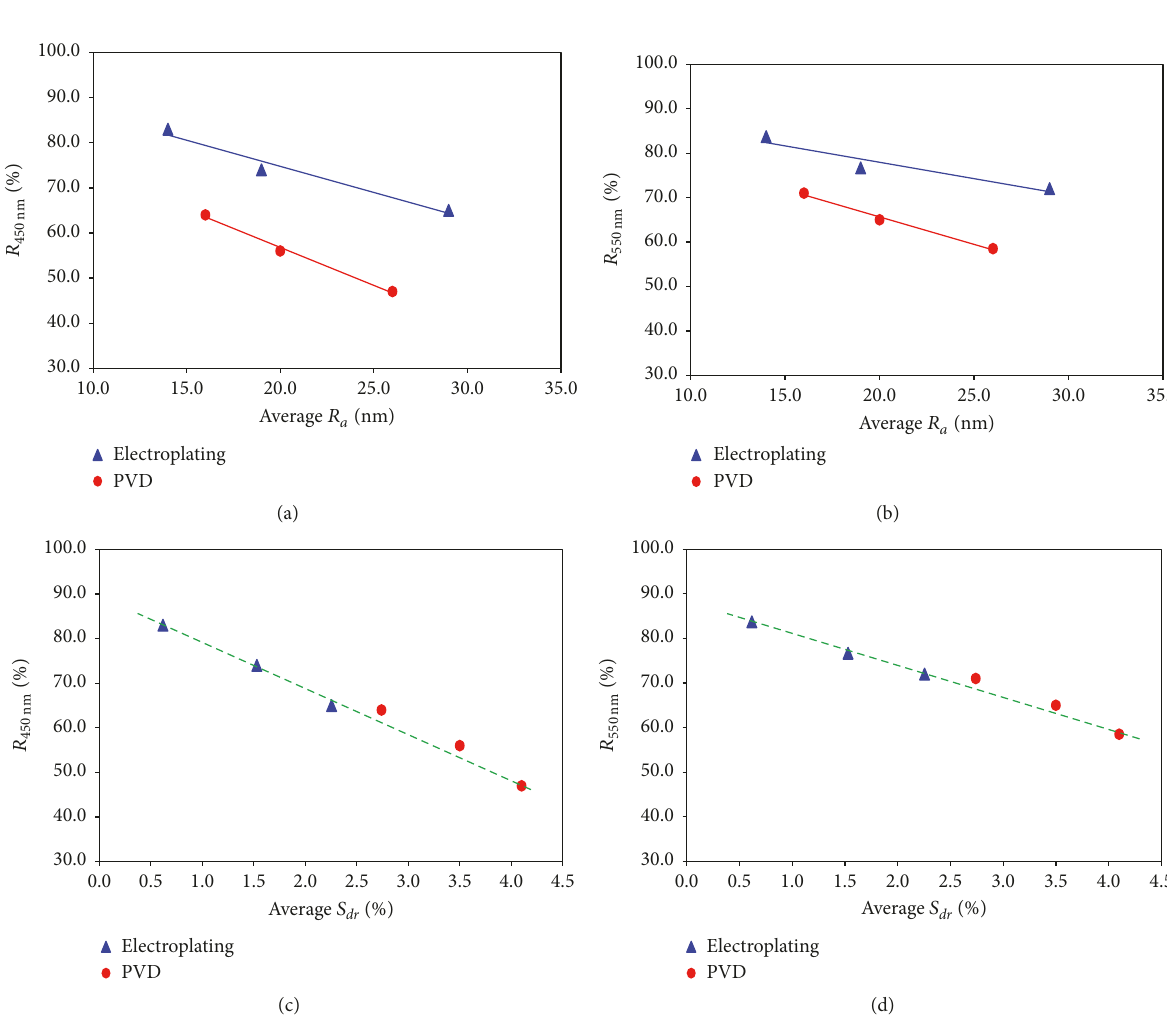
Figure 6: The dependence of specular reflectance of electroplated and physical vapour deposited Ag on the (a-b) average 𝑅 𝑎 ; (c-d) average 𝑆 𝜆 = 450 nm and 550 nm, respectively. 𝑑𝑟 at